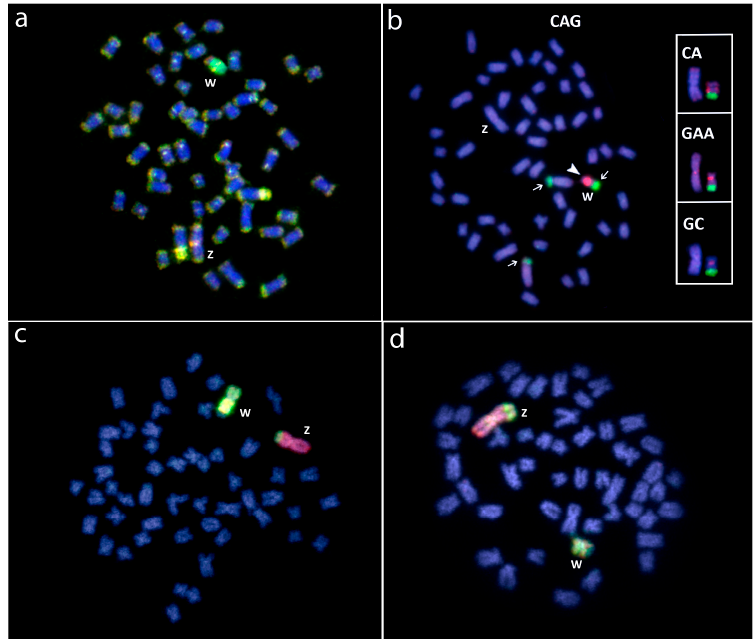
Figure 6. Molecular cytogenetic data in Triportheus species. ( a ) Female T. signatus showing the chromosome superposition of female (green) and male (red) gDNA probes after CGH experiments. Note the large accumulation of female-specific sequences in the W chromosome; ( b ) Female T. signatus chromosomes hybridized with the (CAG) 10 microsatellite. The hybridization pattern on the Z and W chromosomes using (CA) 15 , (CAG) 10 , (GC) 15 microsatellite probes are boxed. Note the preferential accumulation of these repeats on the W chromosome; ( c ) Whole chromosome painting in female T. auritus and ( d ) T. albus (d), using W-chromosome (green) and Z-chromosome (red) probes from T. auritus , providing evidence for the common origin of the ZW sex chromosome system in Triportheus . Bar = 10 µ m. Data from [27,42].